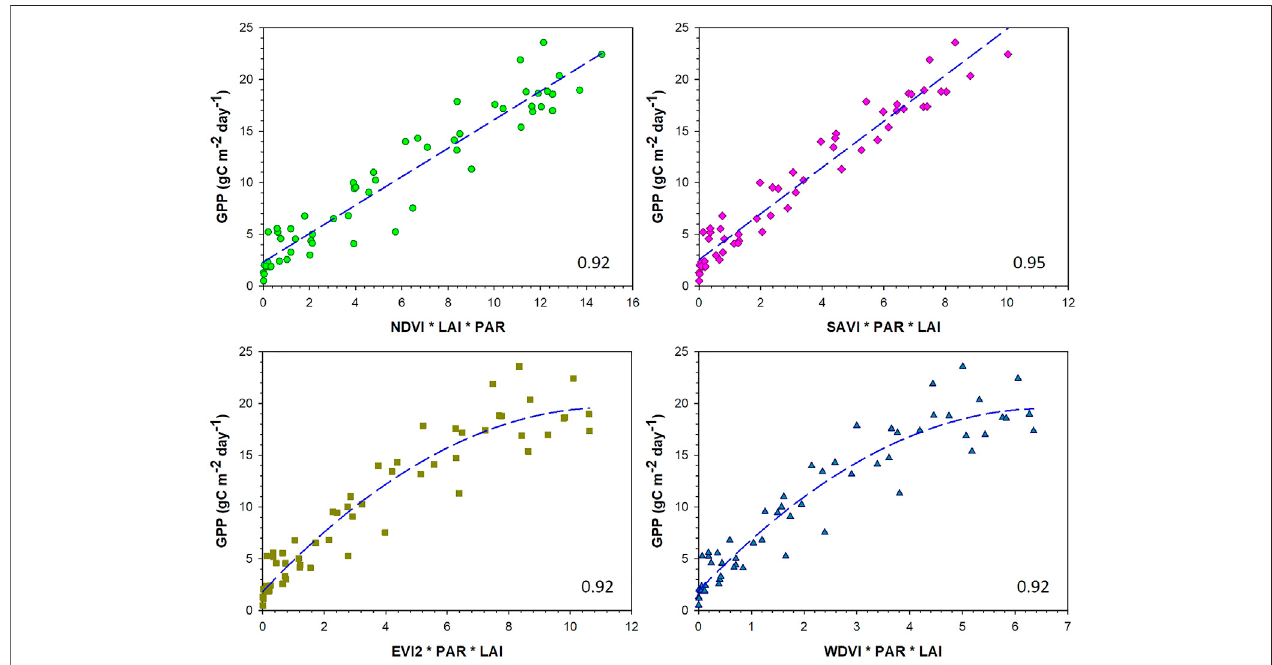
FIGURE 5 | Measured gross primary production (GPP) plotted against the product of vegetation index (VI), photosynthetically active radiation (PAR), and leaf area index (LAI). Vegetation indices include the normalized difference vegetation index (NDVI), the soil adjusted vegetation index (SAVI), the enhanced vegetation index 2 (EVI2), and the weighted difference vegetation index (WDVI).